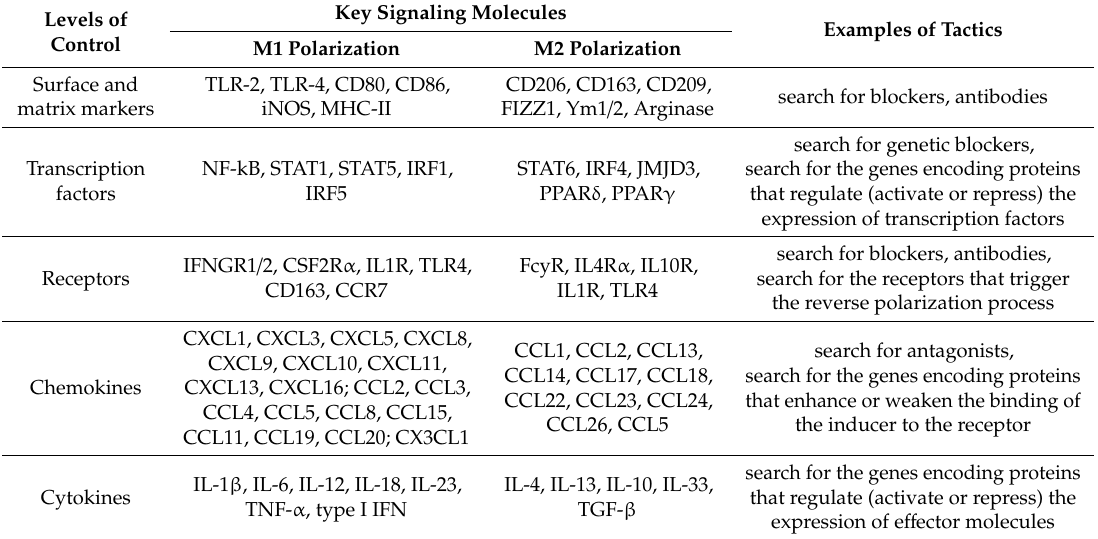
Table 1. The levels of macrophage polarization control, with the lists of key signaling molecules and the feasible tactics of genome target selection (based on